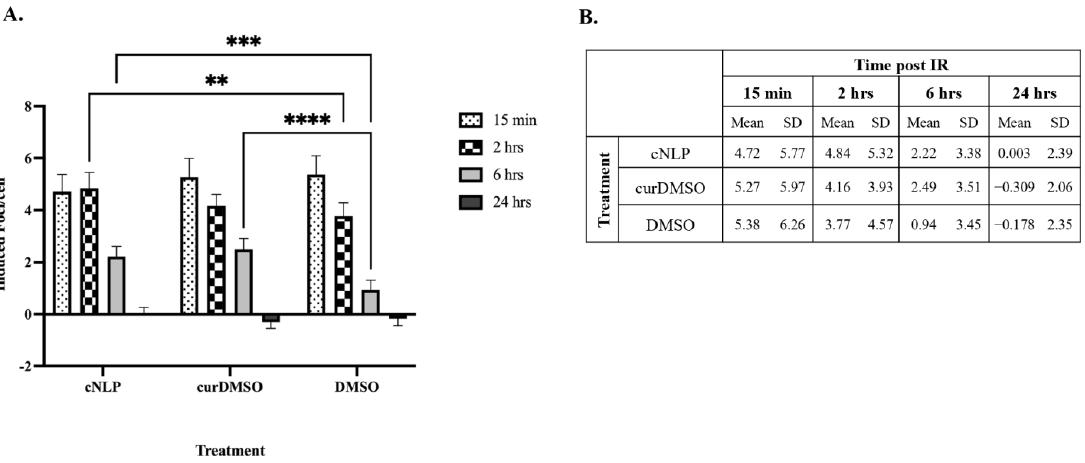
Figure 4. Curcumin pre-treatment alters foci persistence following 137 Cs exposures. AG05965/MRC-5 fibroblasts were pre-treated for 18 h with cNLP, curDMSO, or 0.1% DMSO alone prior to 50 cGy 137 Cs gamma rays. Cells were fixed at 15 min, 2 h, 6 h, and 24 h post-irradiation. Data are mean induced foci per cell with 95% confidence intervals (CI, ( A )) or SD ( B ) at each time point. p -values are labeled as <0.05 (*), <0.01 (**), <0.001 (***), and <0.0001 (****).